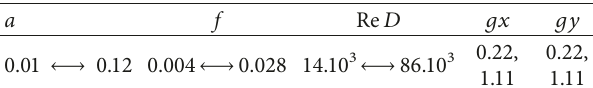
Table 4: Confinement values used for the dynamics